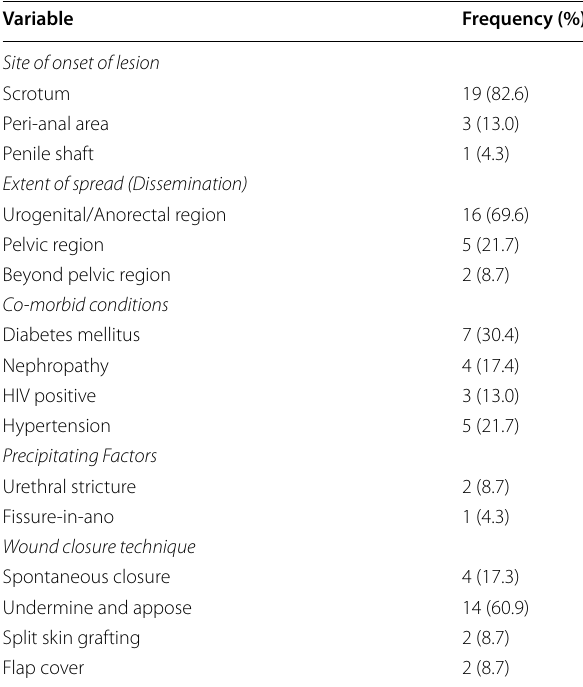
Table 2 Summary of the characteristics of the presenting lesions and the wound closure